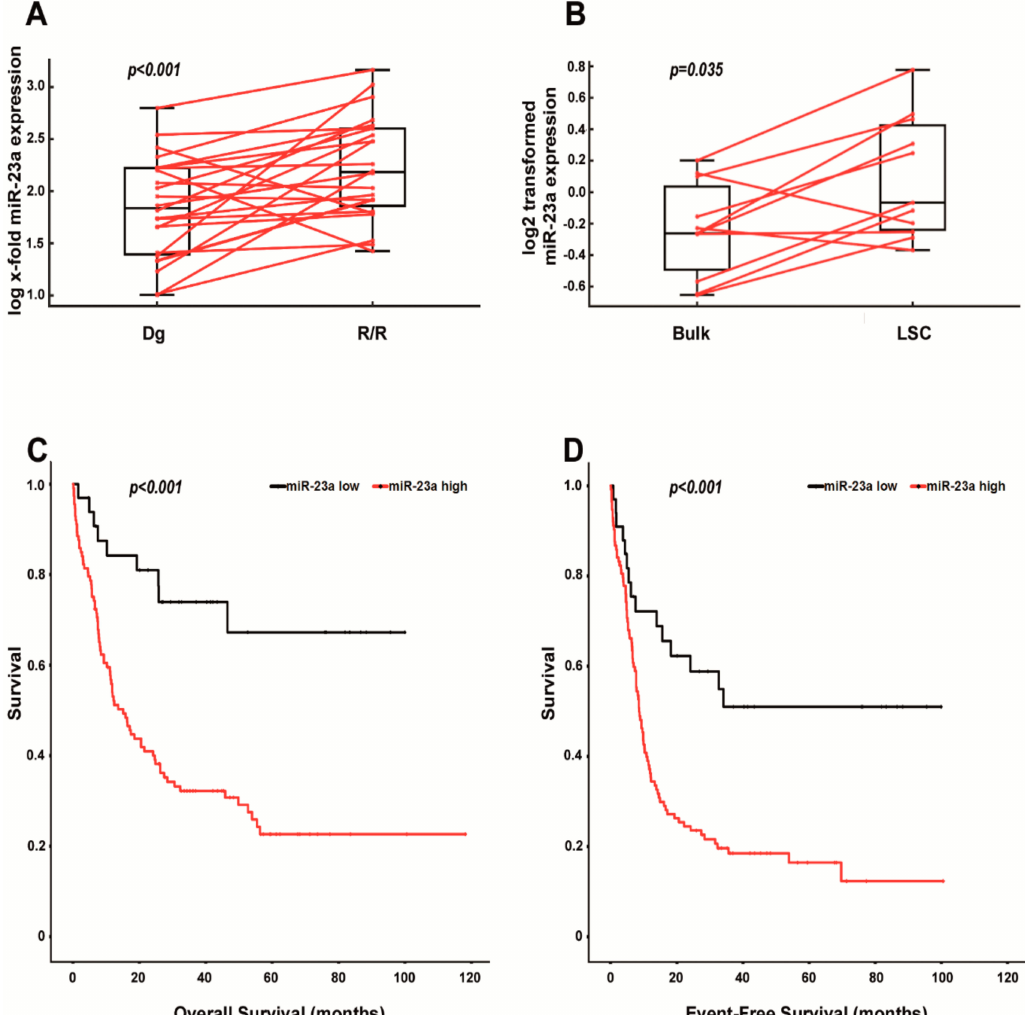
Figure 3. Expression of miR-23a in primary AML patient specimens. ( A ) Box plots displaying miR-23a expression levels in 24 paired AML patient specimens collected at the stage of diagnosis (Dg) and relapsed / refractory disease (R / R). miR-23a expression levels were analyzed by qPCR and are displayed as the log-transformed x-fold expression of the calibrator (NB4 cells). The p -value has been calculated using the Wilcoxon signed-rank test. ( B ) Box plots displaying miR-23a expression levels in eleven AML bulk specimens (Bulk) and the corresponding leukemic stem cell (LSC) compartment. Expression data were downloaded from the Gene Expression Omnibus (http: // www.ncbi.nlm.nih.gov / geo; accession number GSE55916; Ref [13]) and re-analyzed for the expression of miR-23a. The p -value has been calculated using the Wilcoxon signed-rank test. The y -axis displays normalized and log2-transformed miR-microarray expression data, as outlined in more detail previously [13]. ( C , D ) Overall survival ( C ) and event-free survival ( D ) in AML patients treated with AraC-containing high-dose regimens (n = 146) according to the miR-23a expression status. Data were downloaded from the TCGA-AML dataset [35], and re-analyzed for the expression of miR-23a. Statistical significance was calculated by Cox regression